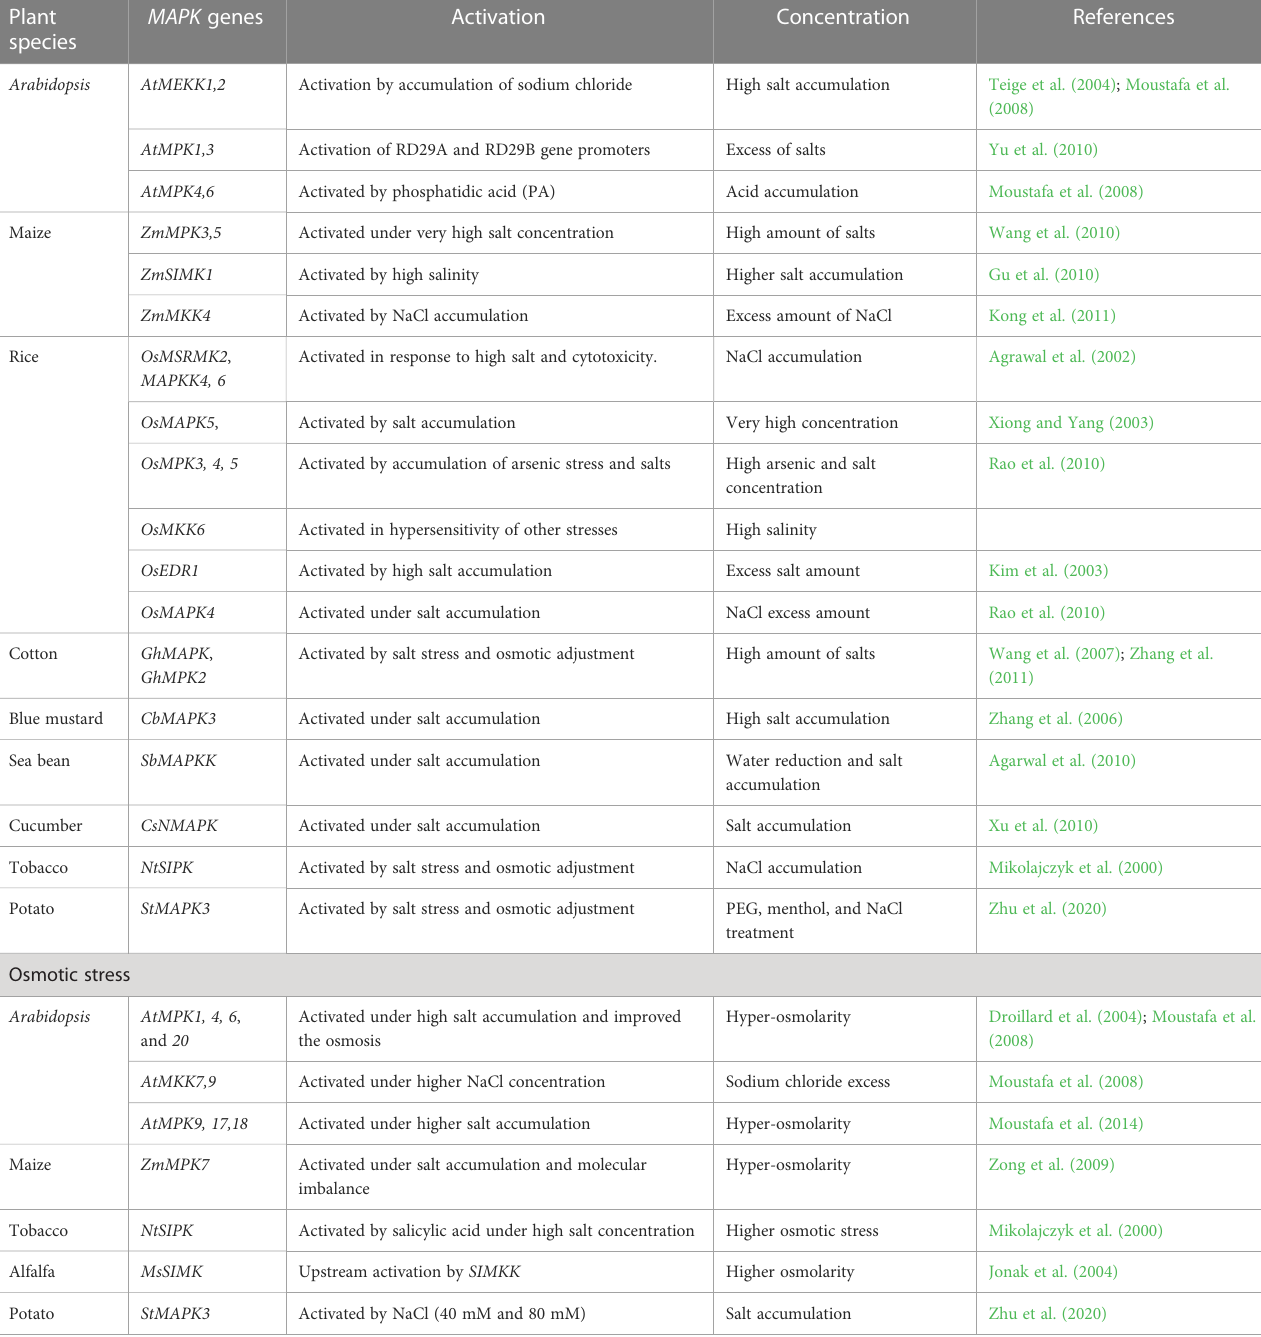
TABLE 4 MAPK gene signaling responses in different plants under salinity stress. MAPK genes Activation Plant species